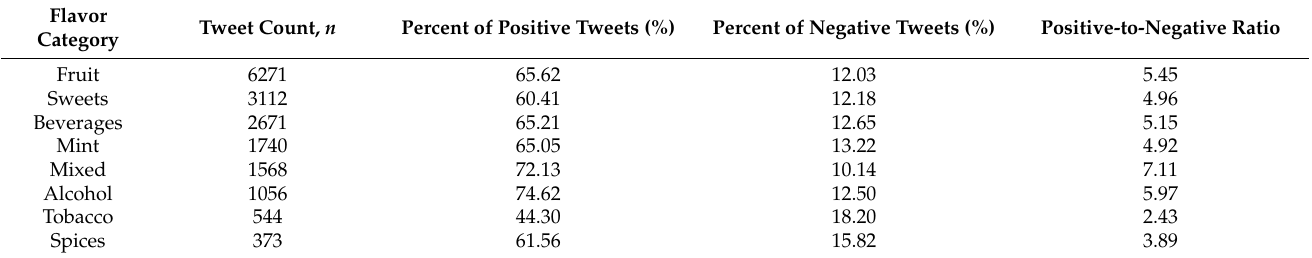
Table 2. Sentiment analysis towards waterpipe flavors on Twitter 1